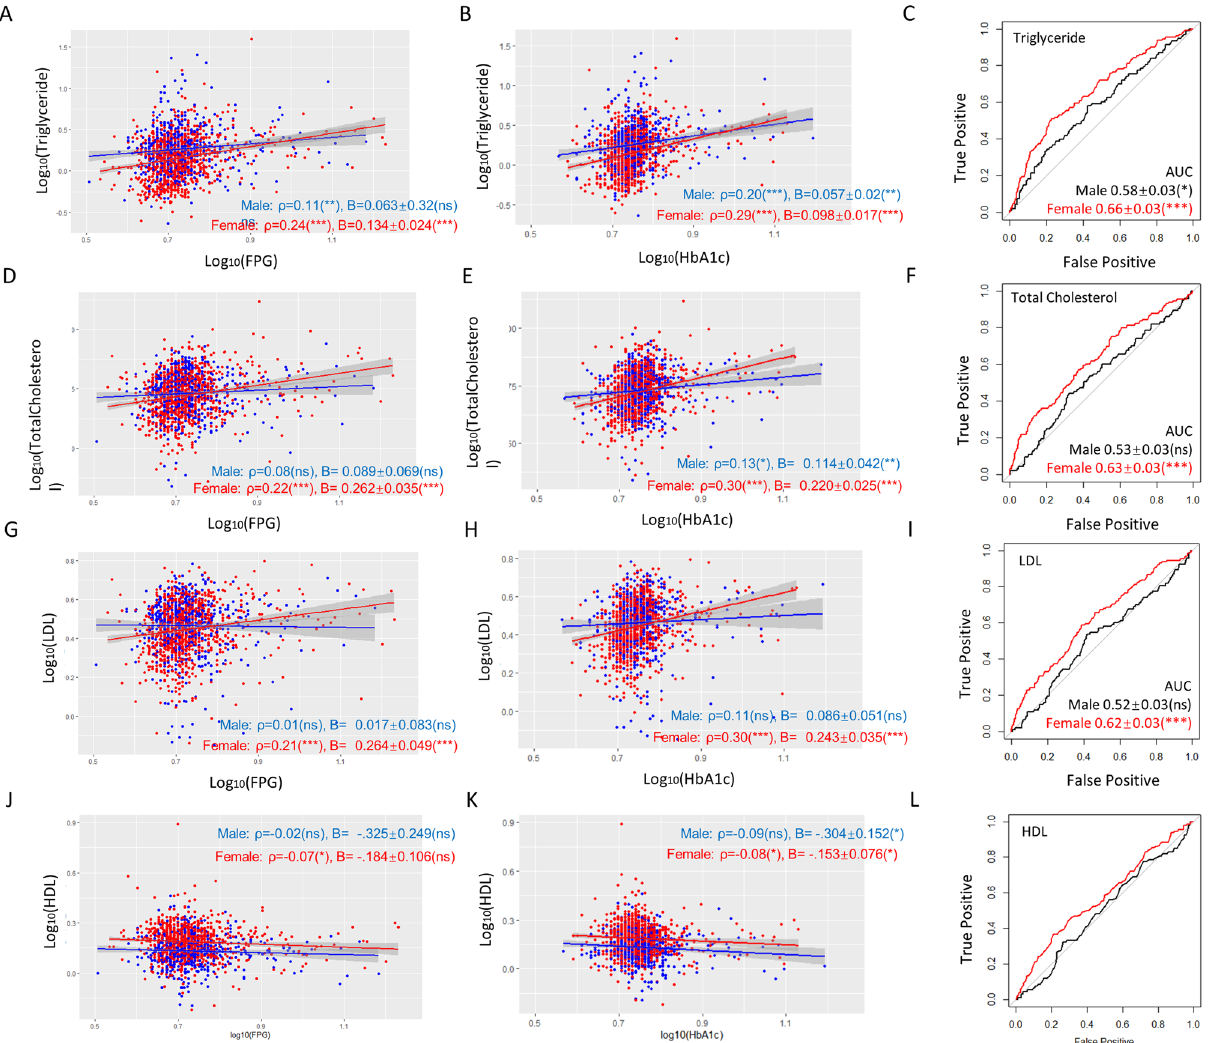
Figure 3. Triglyceride, total cholesterol, and LDL predict T2D better in women than in men. ( A , B ) Triglyceride has a tighter association (Spearman’s ρ) with FPG and HbA1c in women and affects FPG and HbA1c stronger (steeper slope) in women. P values, regression constant can be found in Tables S2 and S3. ( C ) Triglyceride is a stronger T2D predictor for women as judged by ROC-AUC analysis. ( D , E ) Total cholesterol levels tend to have tighter associations with FPG and HbA1c in women and affect FPG and HbA1c levels stronger in women. ( F ) Total cholesterol is a stronger T2D predictor for women. ( G , H ) LDL levels associate with FPG and HbA1c stronger in women and tend to affect FPG and HbA1c levels stronger in women. ( I ) LDL levels predict T2D in women but not men as judged by ROC-AUC analysis. ( J , K ) HDL has a very weak, negative correlation with FPG and HbA1c and shows no sex-difference. ( L ) HDL predicts T2D better in women than in men. AUC area under the curve, ns not significant, *P < 0.05, **P < 0.01, ***P <